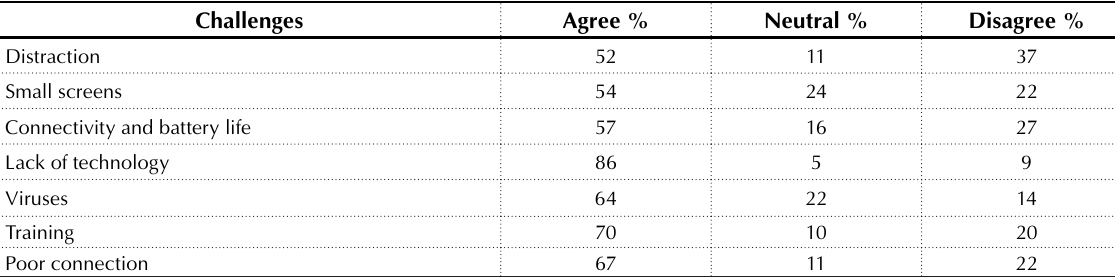
Table 2. Challenges faced by lecturers and